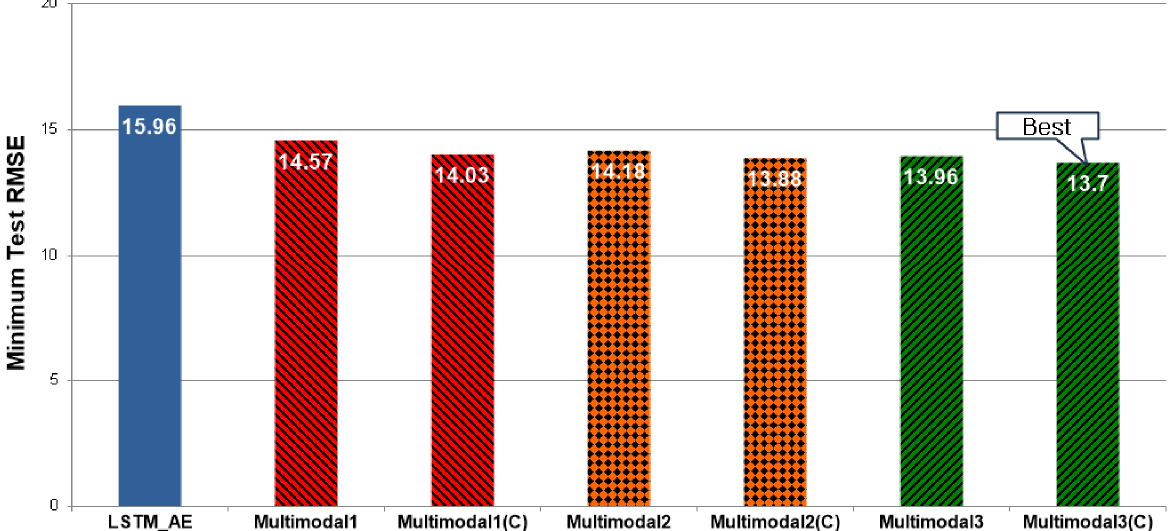
Figure 13. Minimum Test RMSE of all experimental results.